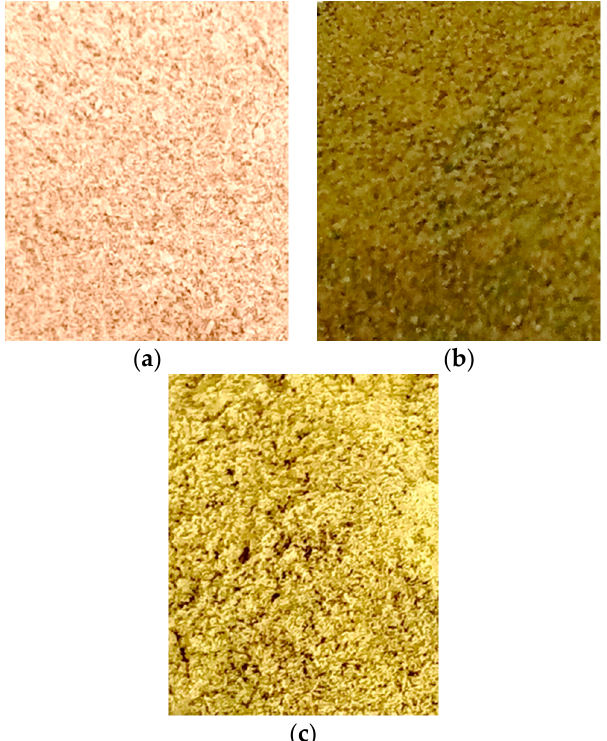
Figure 1. Physical appearance of ( a ) Bambara groundnut protein isolate (BGNPI), ( b ) Moringa oleifera protein isolate (MOLPI), and ( c ) Bambara groundnut- Moringa oleifera leaf protein complex (BAMOLP).